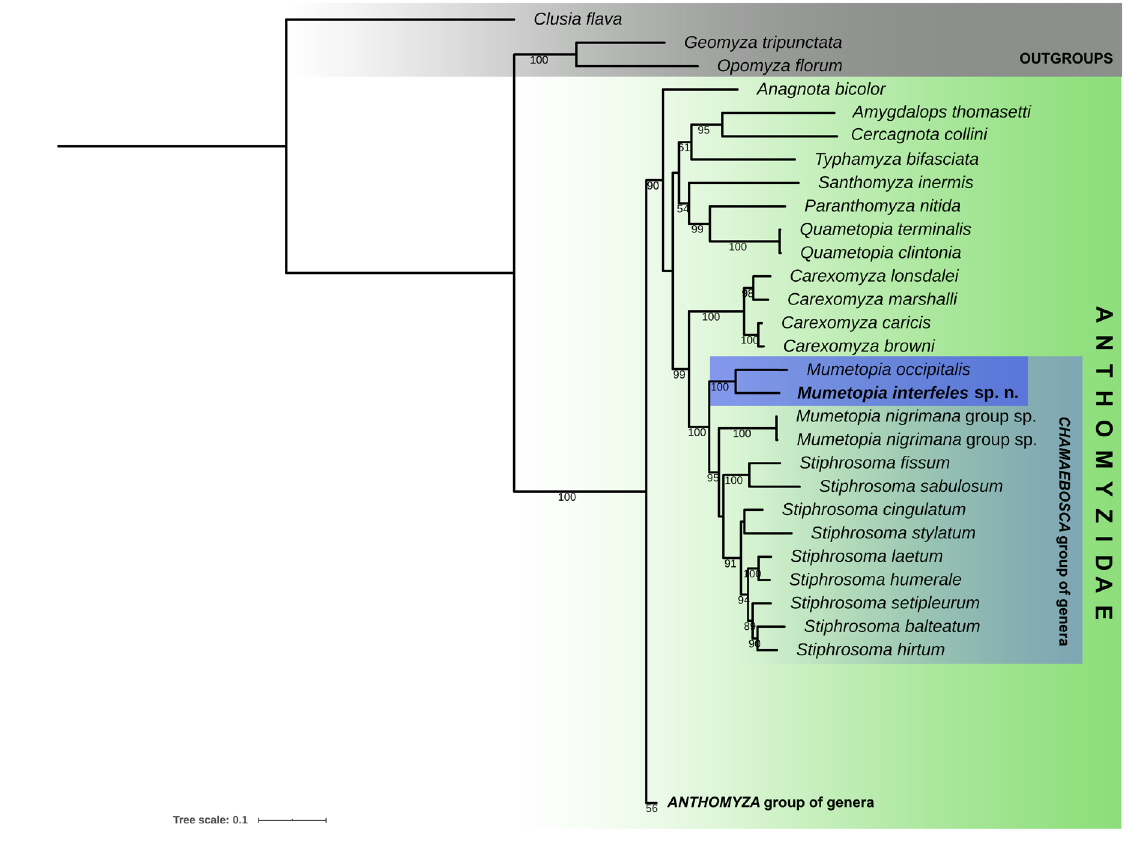
Fig. 33. RAxML hypothesis for relationships of Anthomyzidae based on DNA sequence data (12S, 16S, 28S, COI, COII, CytB, ITS2) representing 4583 characters, without the Anthomyza group of genera clade displayed. Numbers below nodes = bootstrap support